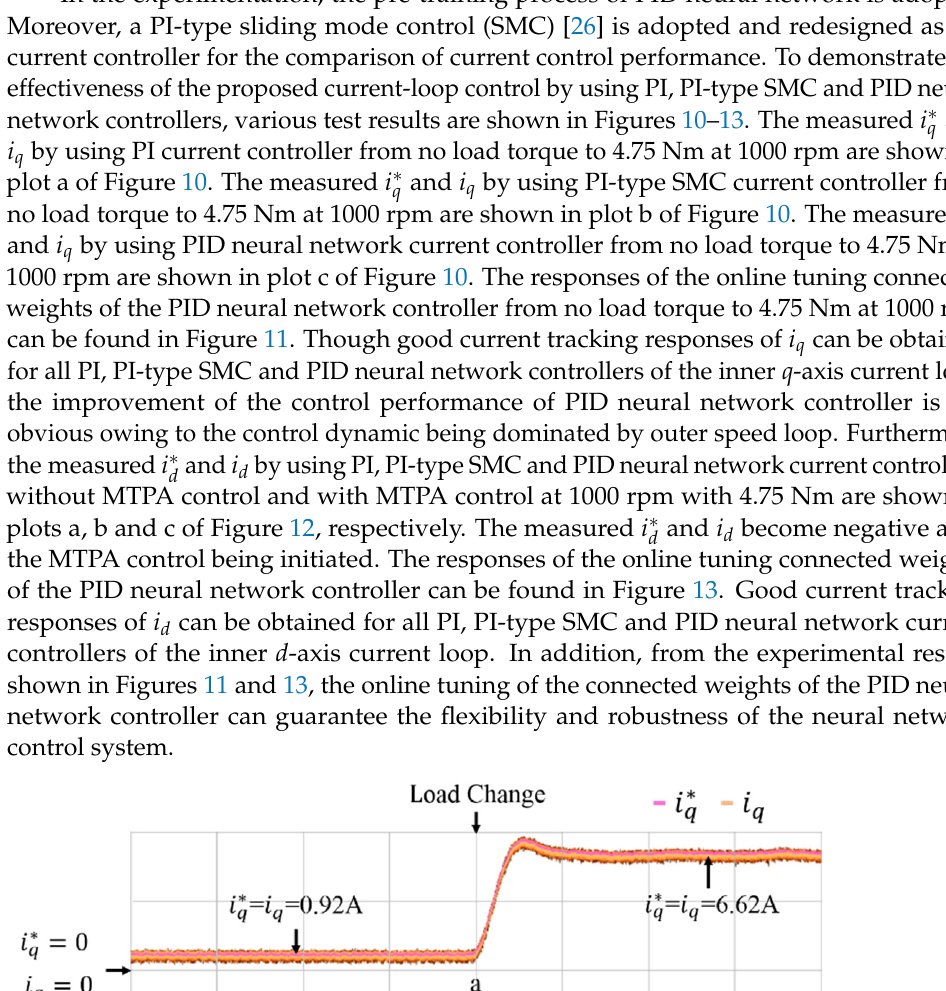
Figure 11. Variations of connected weights of the PID neural network of q -axis current-loop from no load torque to 4.75 Nm load torque at 1000 rpm. Figure 12. Measured * d i and d i by using PI current controller from without MTPA control to with MTPA control at 1000 rpm with 4.75 Nm: (a) using PI current controller; (b) using PI-type SMC current controller; (c) using PID neural network current controller.